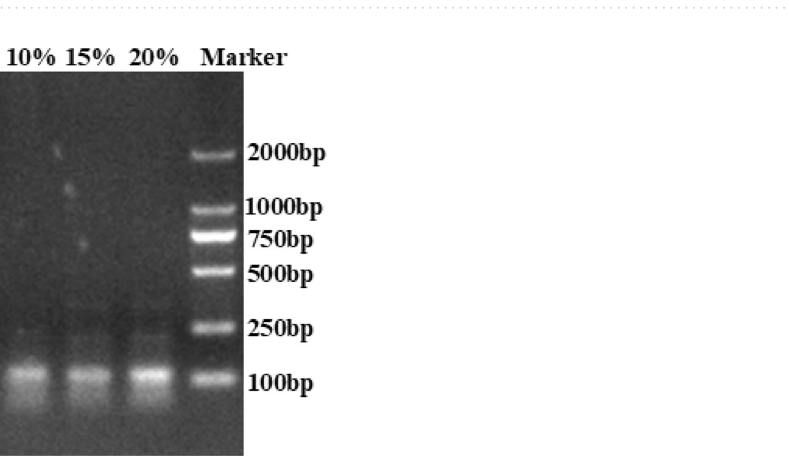
Figure 8. Electrophoretic detection of magnetic beads adsorption ability under different PVA